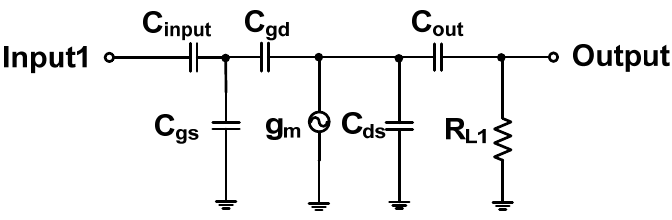
Figure 3. Equivalent circuit model of the HVPA.